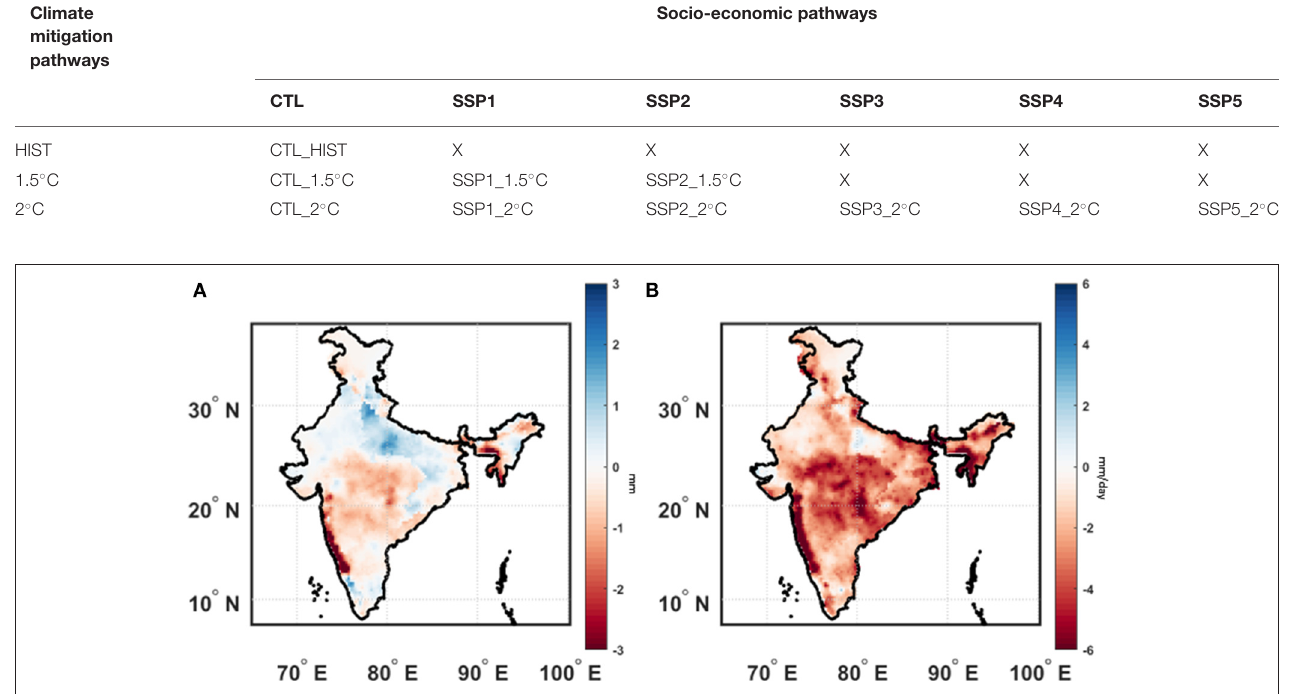
TABLE 1 | Scenario matrix used in the study.